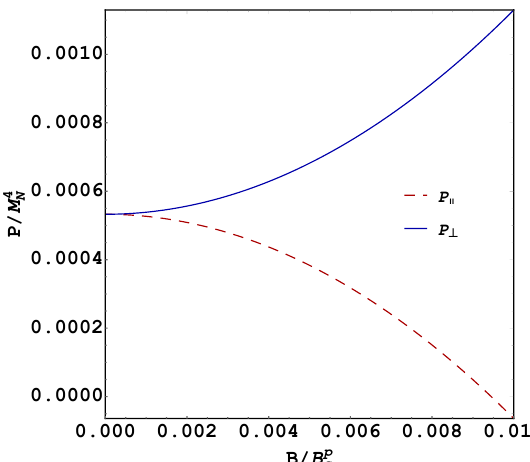
Figure 1. (Color online) Parallel and perpendicular pressures as a function of the magnetic field at a fixed chemical potential µ = 2.25 GeV. Here, B by equating the proton magnetic energy to its rest energy.